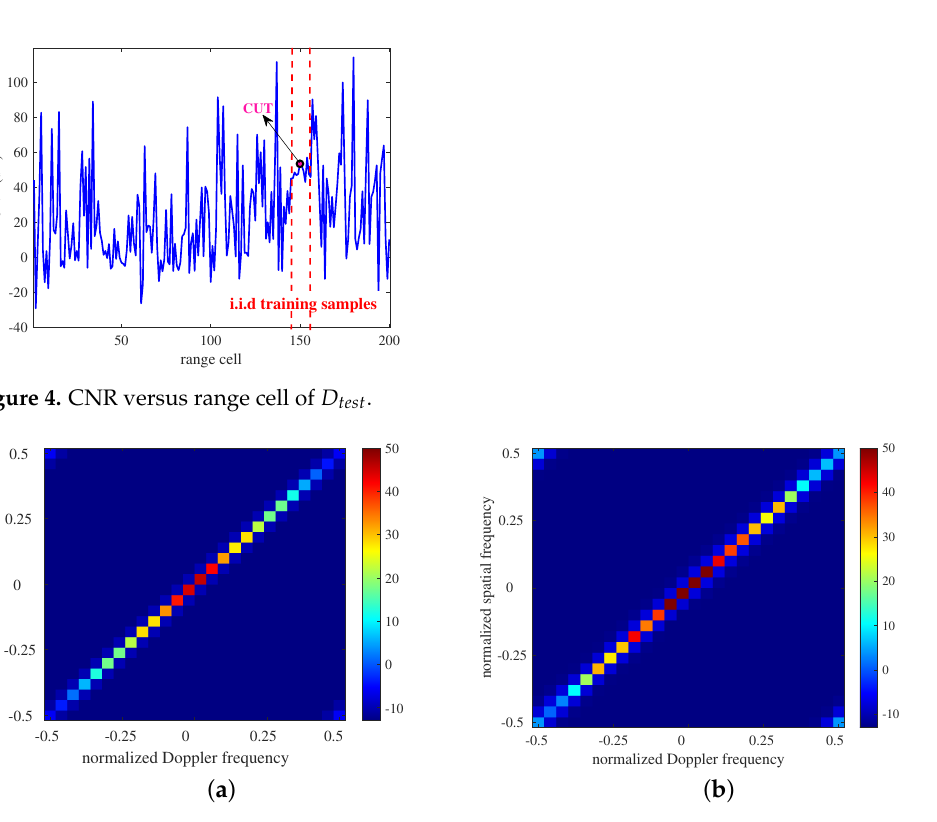
Figure 5. Estimated angle − Doppler clutter spectrum after pre − training. ( a ) Clairvoyant spectrum calculated by known CCM. ( b ) Estimated clutter spectrum using 128 training